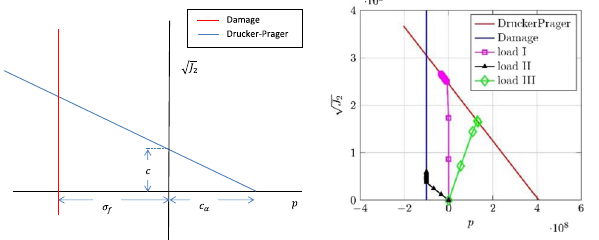
Fig. 9 Inelastic model and load path. Left: elastic domain with Drucker–Prager yield and compression damage. Right: identifica- tion load paths